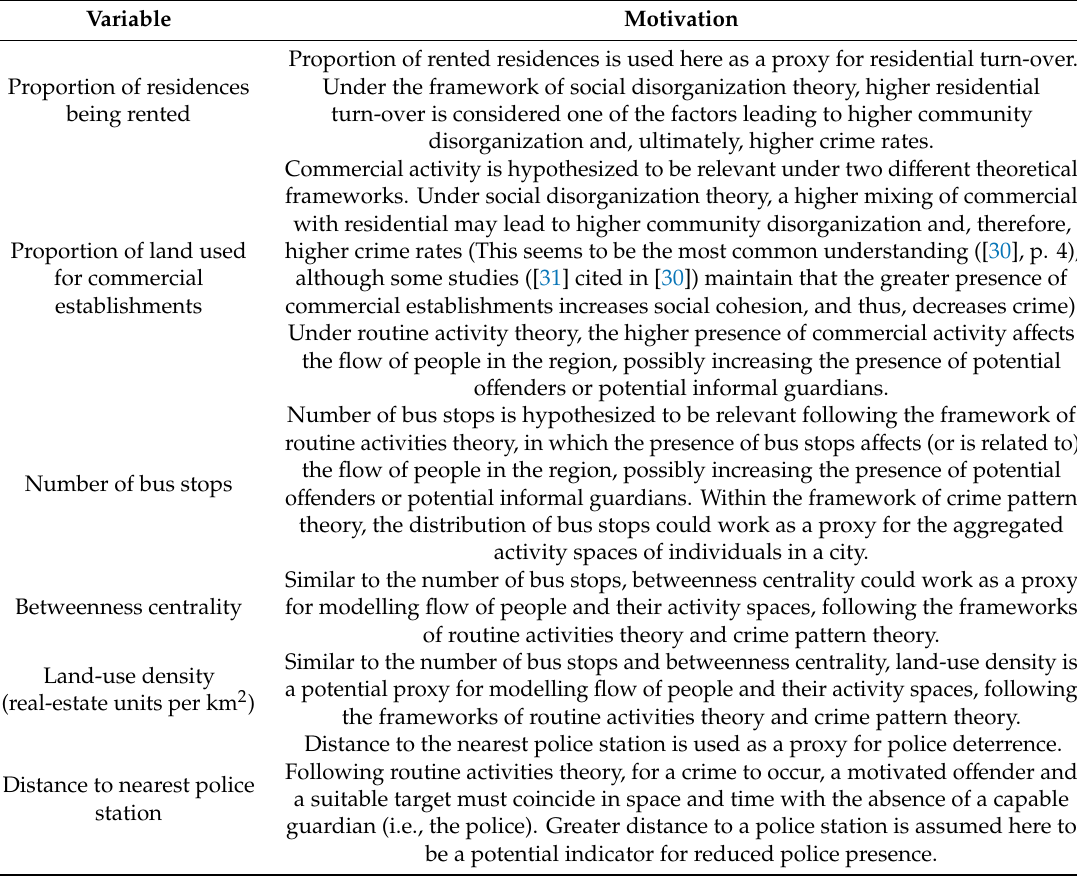
Table 1. List of control variables used, and their